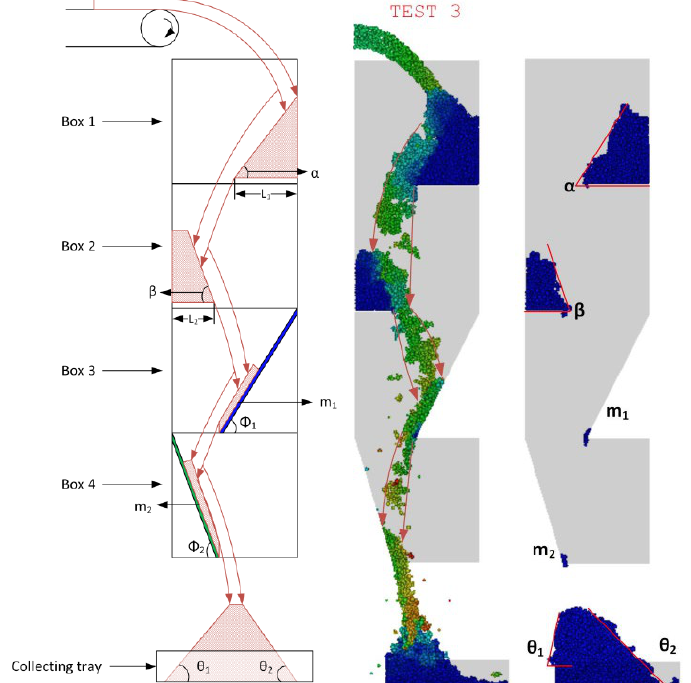
Figure 11. Flow test apparatus as adapted from [105]. Reproduced with permission from W.